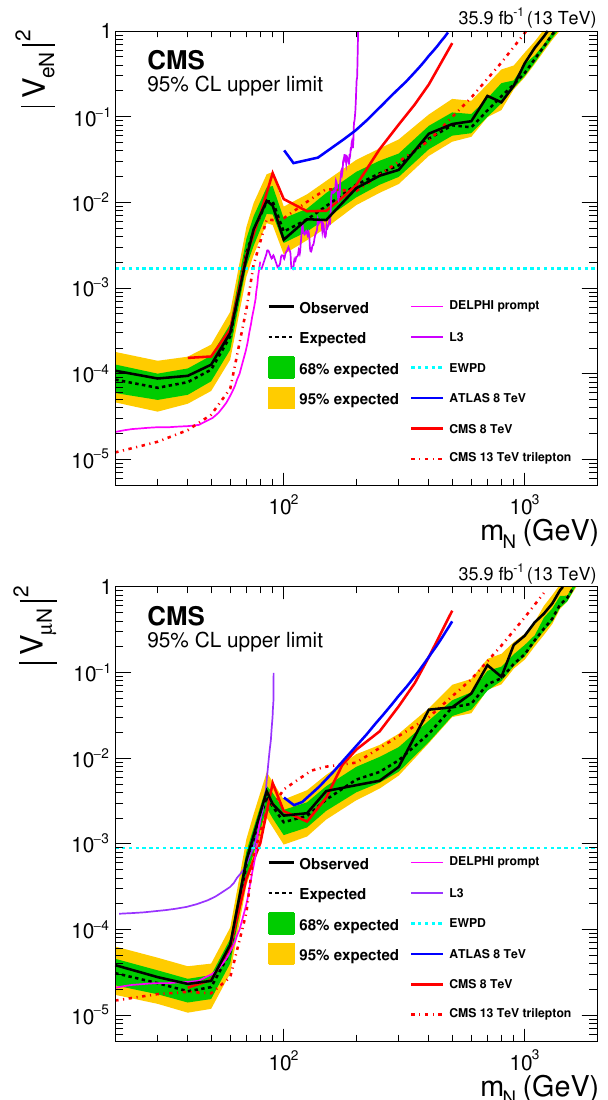
2 (upper) and 2 (lower) vs. m V eN V (cid:22) N N plane. The j j j j